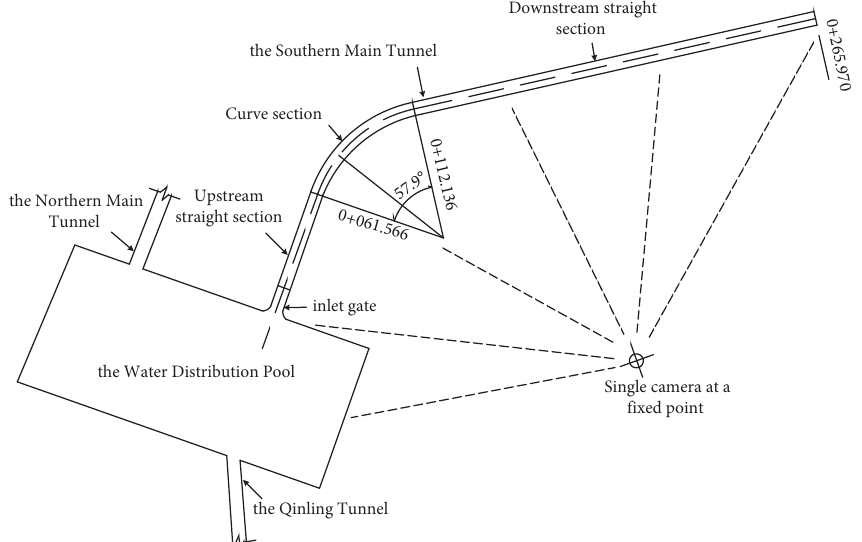
Figure 1: Te original scheme for measuring the instantaneous water level by erecting steel rulers at multiple points using a single